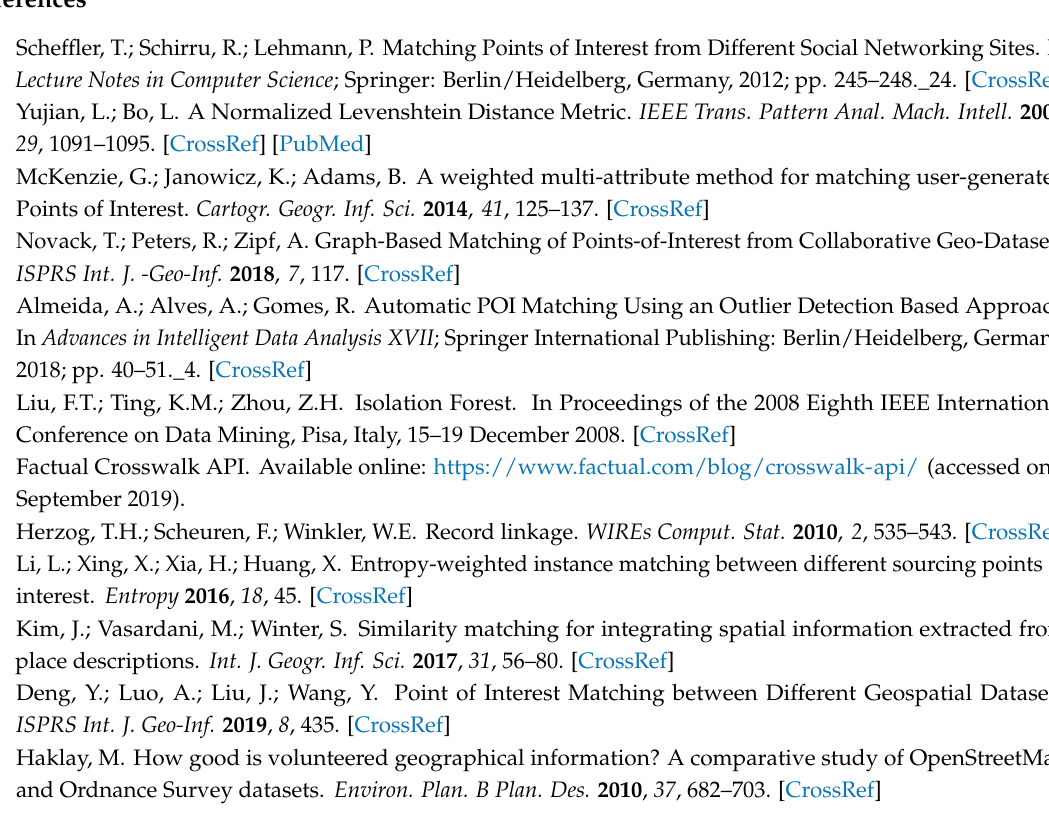
Figure A5. A receiver operating characteristics for all considered category similarity metrics for all four strategies for dealing with missing data for attribute Category